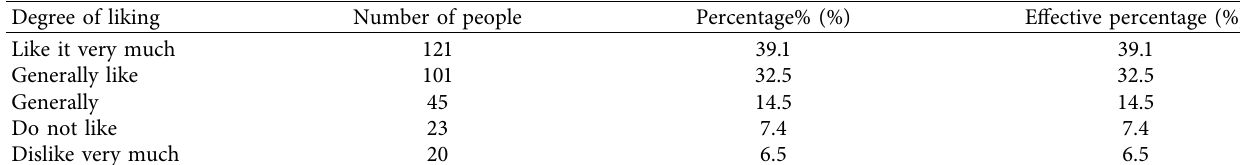
Table 5: Popularity of game B